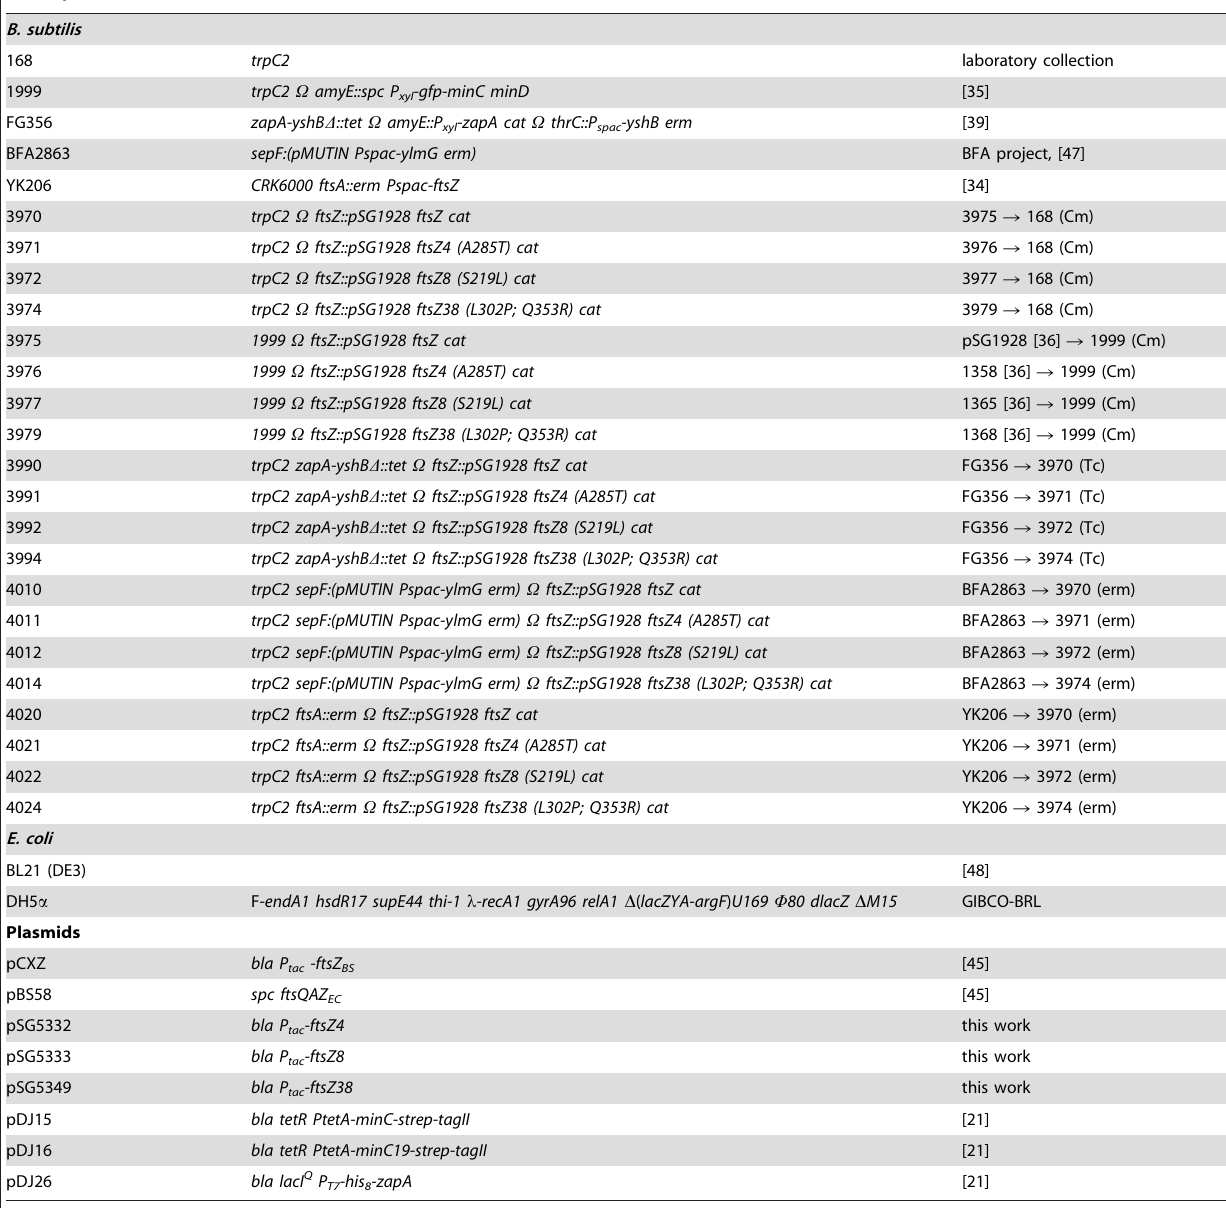
Table 2. Strains and